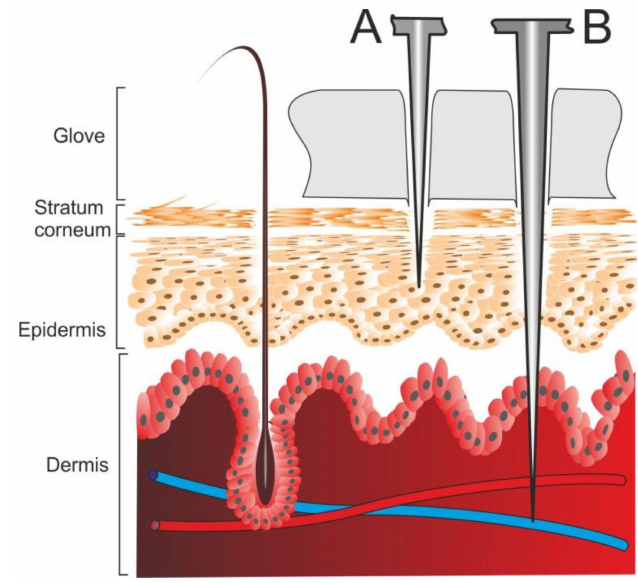
Figure 6. Cross-section schematic of the skin interface emphasising the effect of needle length on penetration